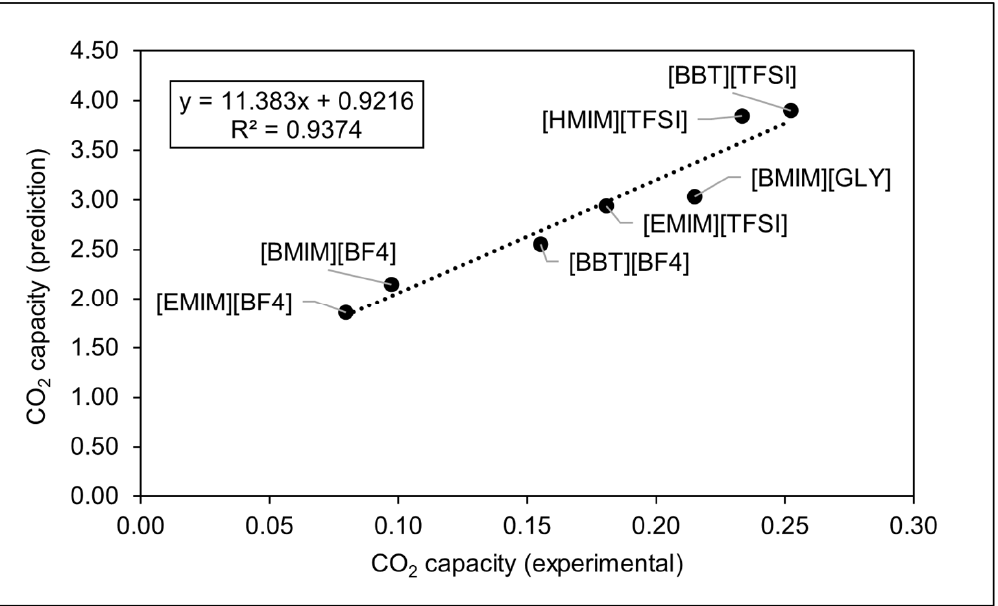
Figure 4. Quantitative comparison between experimental and computational CO 2 capacity.